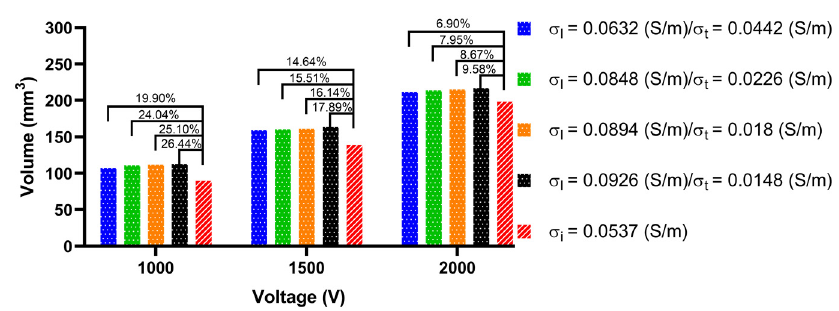
Figure 14. The statistical results of the size of the ablation isosurface under the condition of different PFA amplitudes at ablation target 3. The statistical results of the size of the ablation isosurface in myocardial electrical conductivity ( a ) group 1; ( b ) group 2; ( c ) group 3; and ( d ) group 4.